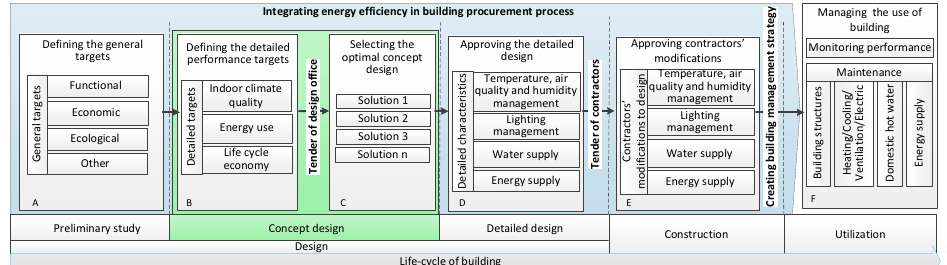
Figure 3. The municipal building procurement process from the municipal building departments’